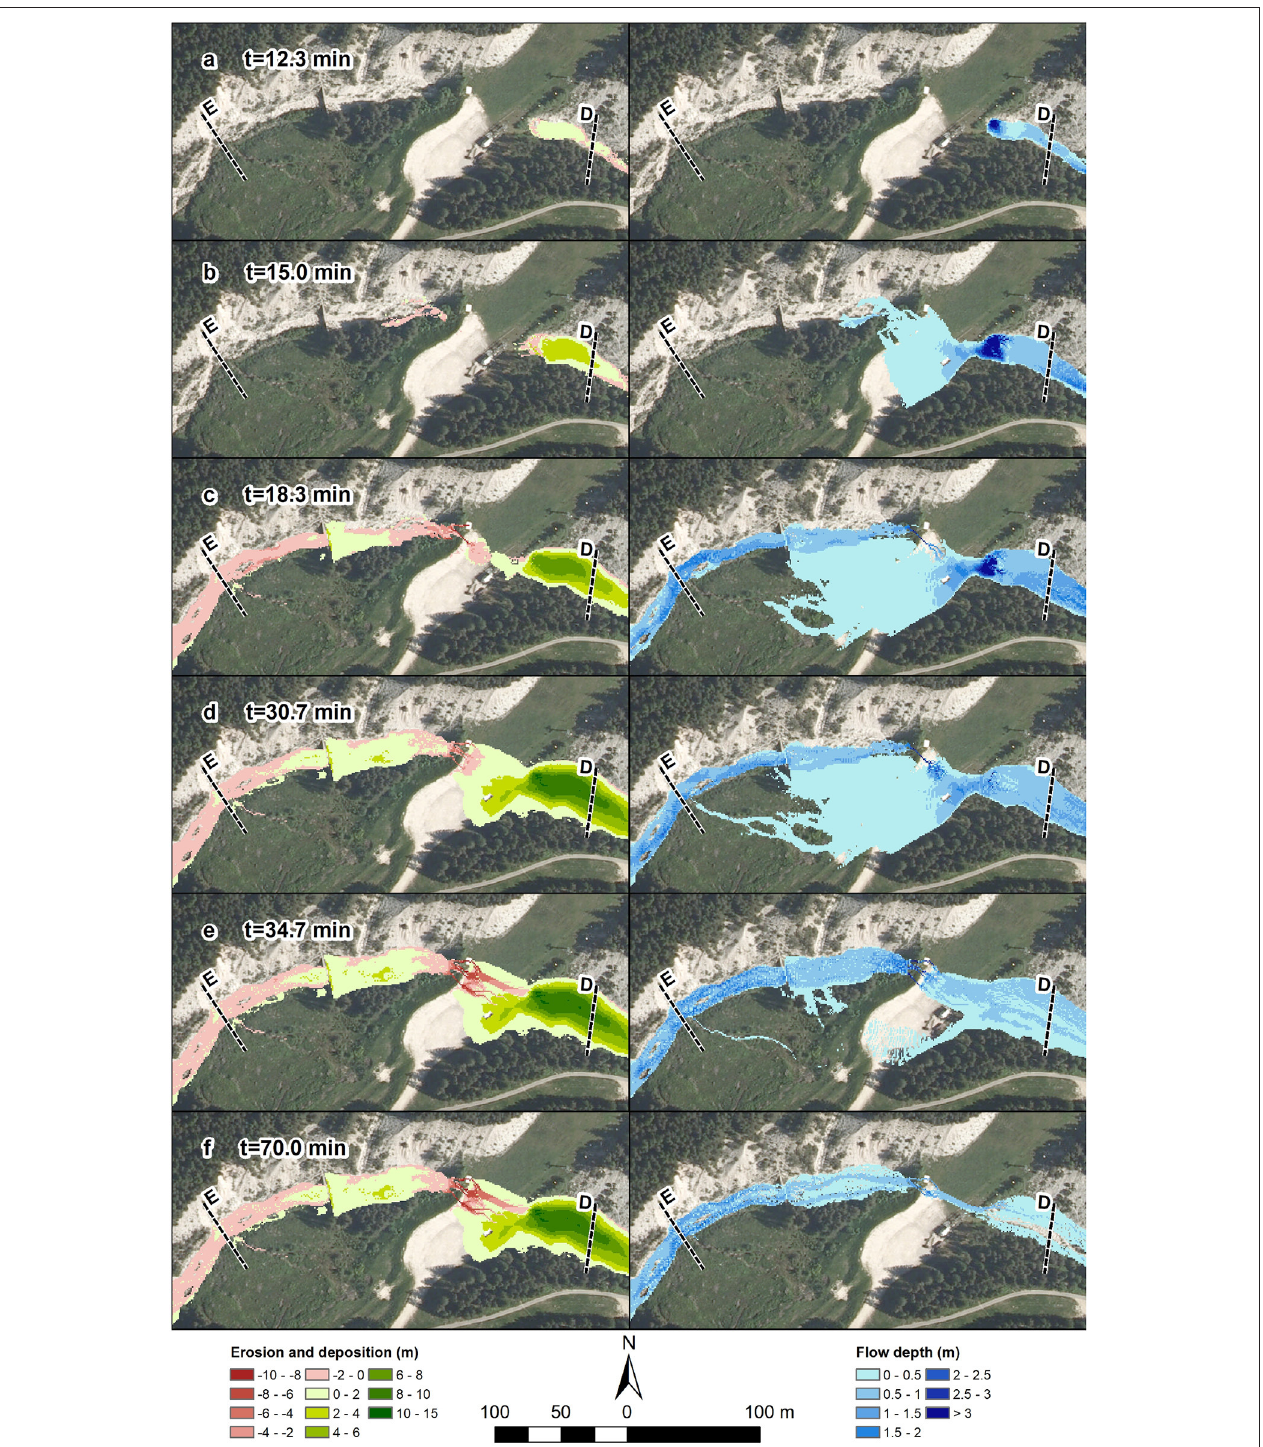
FIGURE 12 | The deposition and erosion depths (Left) and flow depths (Right) maps at different times [ (a) t = 12.3 min, (b) t = 15.0 min, (c) 18.3 min, (d) t = 30.7 min, (e) t = 34.7 min, (f) t = 70.0 min] from the beginning of the simulation of the area close to the culvert and parking.